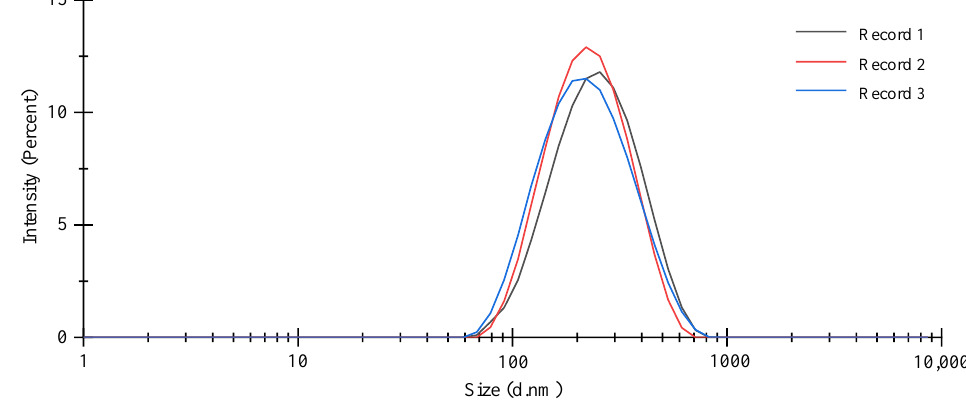
Foods 2022 , 11 , x FOR PEER REVIEW